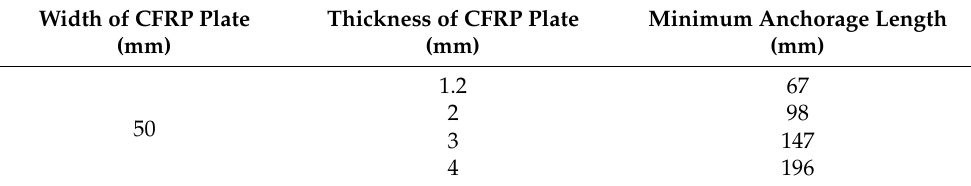
Table 1. Anchorage lengths of CFRP